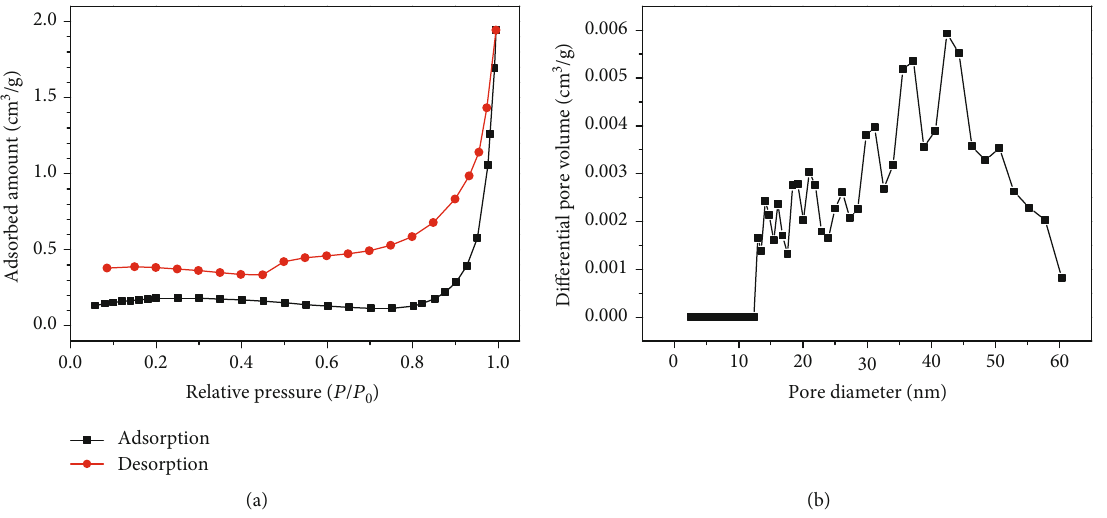
Figure 1: N adsorption and desorption isotherms at 77 K (a) and the pore size distribution of mesopore and macropore (b). 2 Table 1: Pore structure parameters of QS sample determined from N